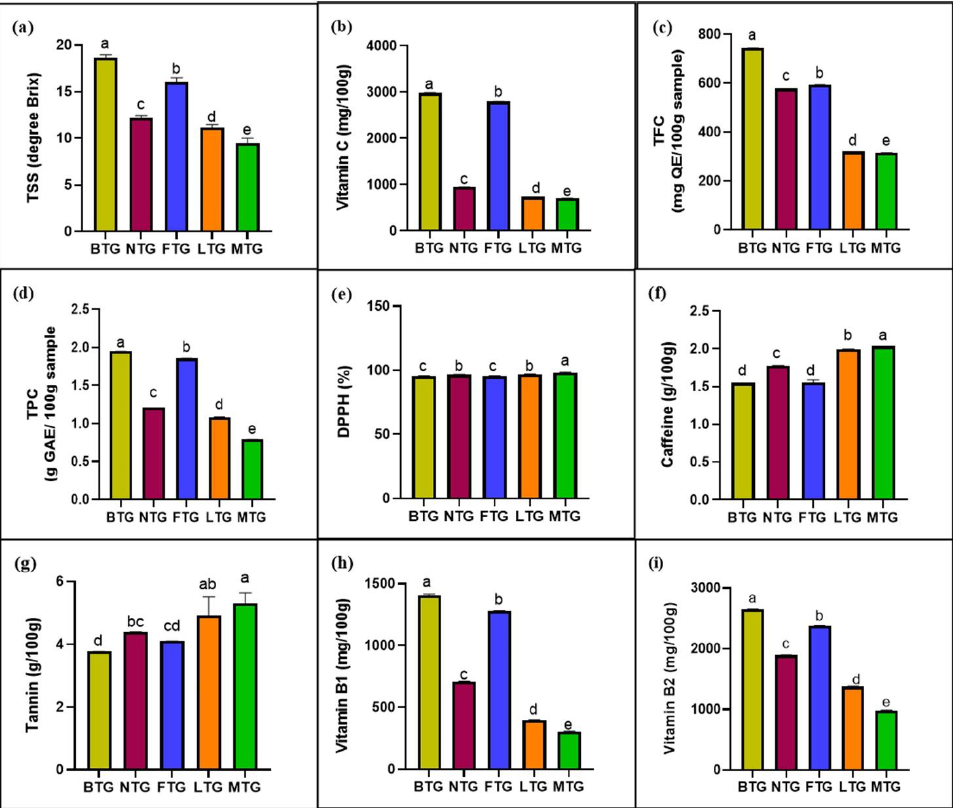
Figure 4. Effect of reduced soil pH on biochemical and nutritional qualities of tea leaf. ( a ) TSS, ( b ) vitamin C, ( c ) TFC, ( d ) TPC, ( e ) DPPH, ( f) caffeine, ( g ) tannin, ( h ) vitamin B1, and ( i ) vitamin B2 of tea leaf in BTG, NTG, FTG, LTG and MTG. BTG: BTRI Tea Garden, NTG: Nurjahan Tea Garden, FTG: Finlay Tea Garden, LTG: Lakkatora Tea Garden, MTG: Malnichara Tea Garden, TSS: total soluble solid (degree Brix), vitamin C (mg/100 g), TFC: total flavonoid content (mg QE/100 g sample), TPC: total polyphenol content (g GAE/100 g sample), DPPH: 2,2-diphenyl-1-picryl-hydrazyl (% scavenging activity), caffeine (g/100 g), tannin (g/100 g), vitamin B1 (mg/100 g), vitamin B2 (mg/100 g). The statistics given are the averages of three replicates, with the vertical bars indicating the standard deviation. According to least significant difference test, the means signified by the same letter did not differ substantially at p < 0.01.